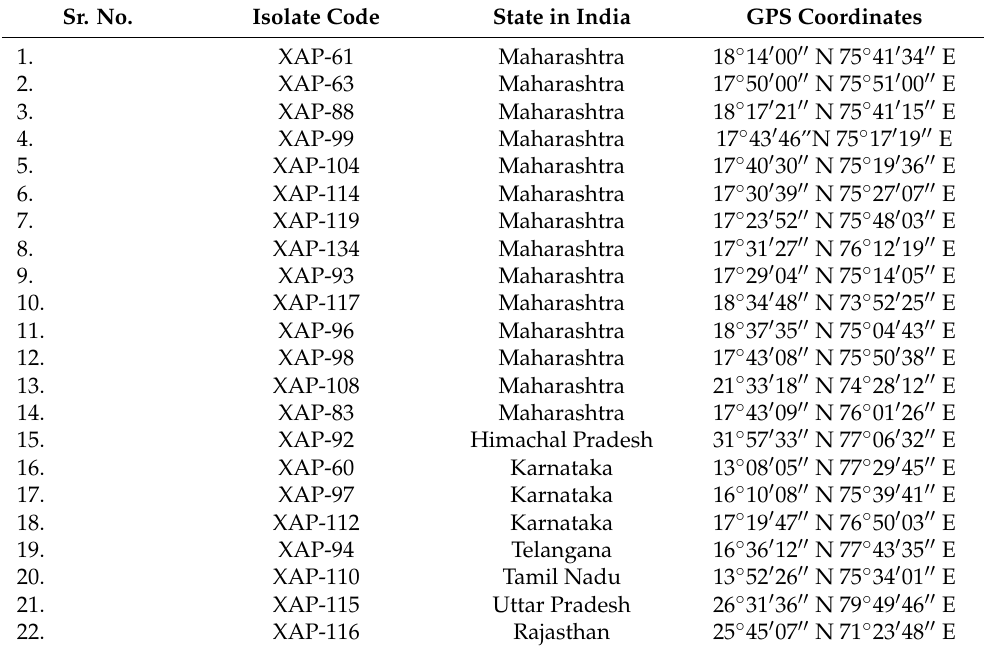
Table 1. Details of geographical origin of Xap